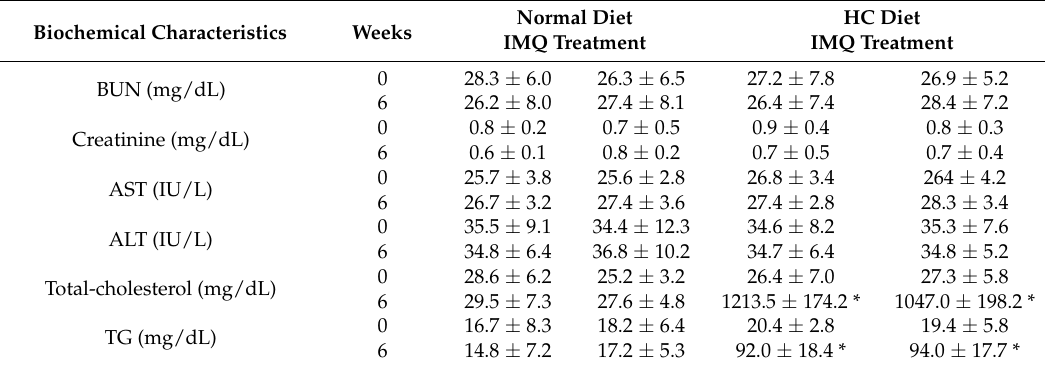
Table 1. Plasma biochemical characteristics ( n = 5) in experimental